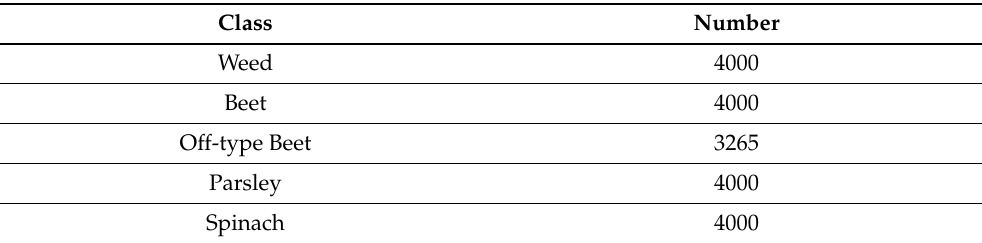
Table 1. Class Distribution.